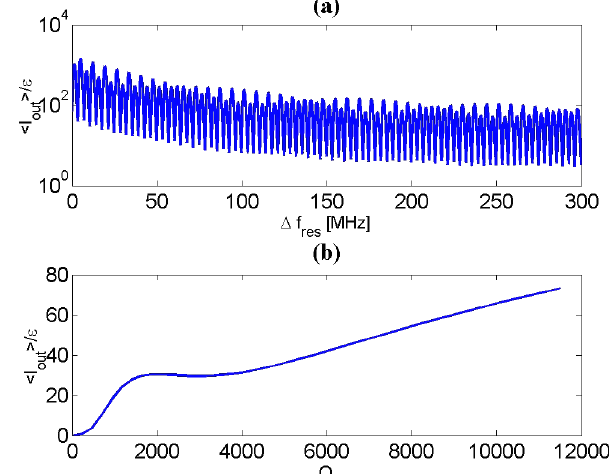
FIG. 8. (a) Beam spectrum lines of a single train of 400 bunches that perform an infinite number of turns in the CR. (b) FFT of the vertical oscillation signal of Fig. 7.